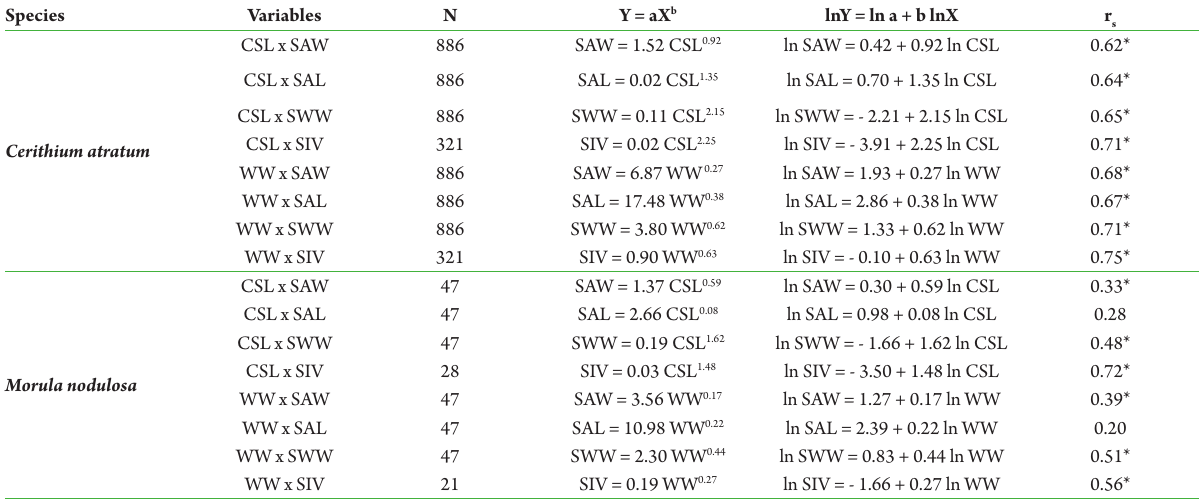
= Spearman correlation coefficient]. s